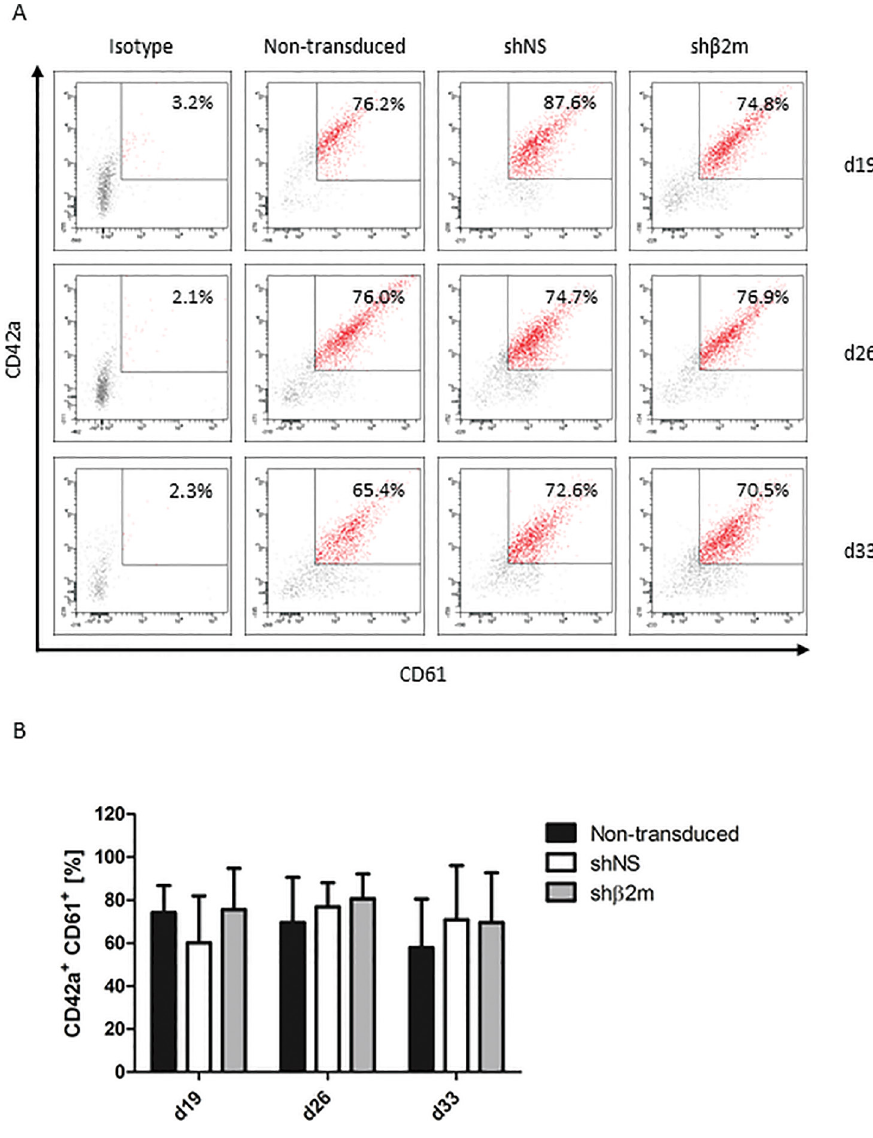
Figure 5. Characterization of HLA class I-silenced iPSC-derived platelets (PLTs). Nontransduced iPSCs and iPSCs expressing either a control nonspecific short-hairpin RNA (shNS) or a shRNA targeting β 2-microglobulin transcripts (sh β 2m) were cultured for 33 d and analyzed weekly from d 12 for PLT differentiation (four time points). (A) PLTs were identified by selection of a CD41 + (GPIIb) population. Shown is the percentage of CD42a + (GPIX) CD61 + (GPIIIa) co-expression of CD41 + cells. Representative flow cytometry dot plots are shown for each condition and time point. (B) Mean and SD of CD42a + CD61 + cells of four independent